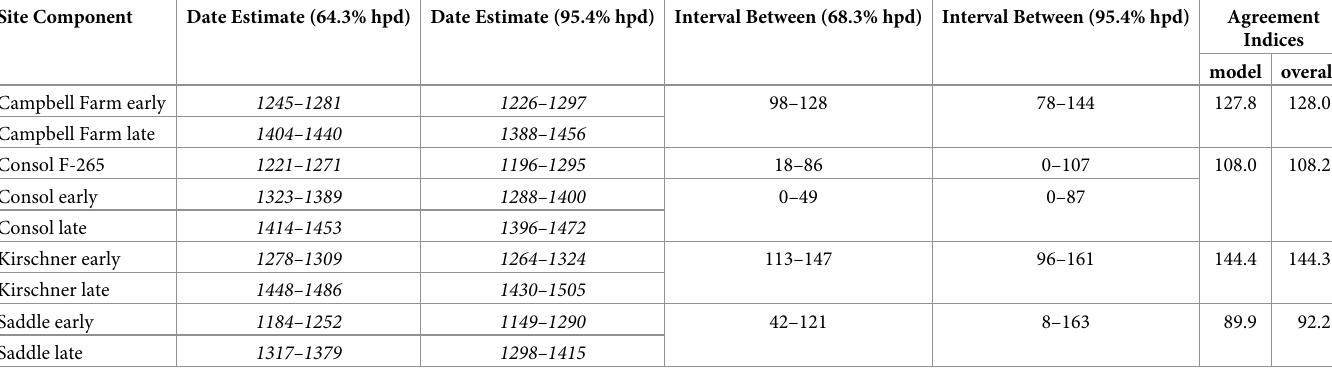
Table 1. Date estimates of and intervals between site-specific sequential Phases in southwestern Pennsylvania south of the Ohio River. Site